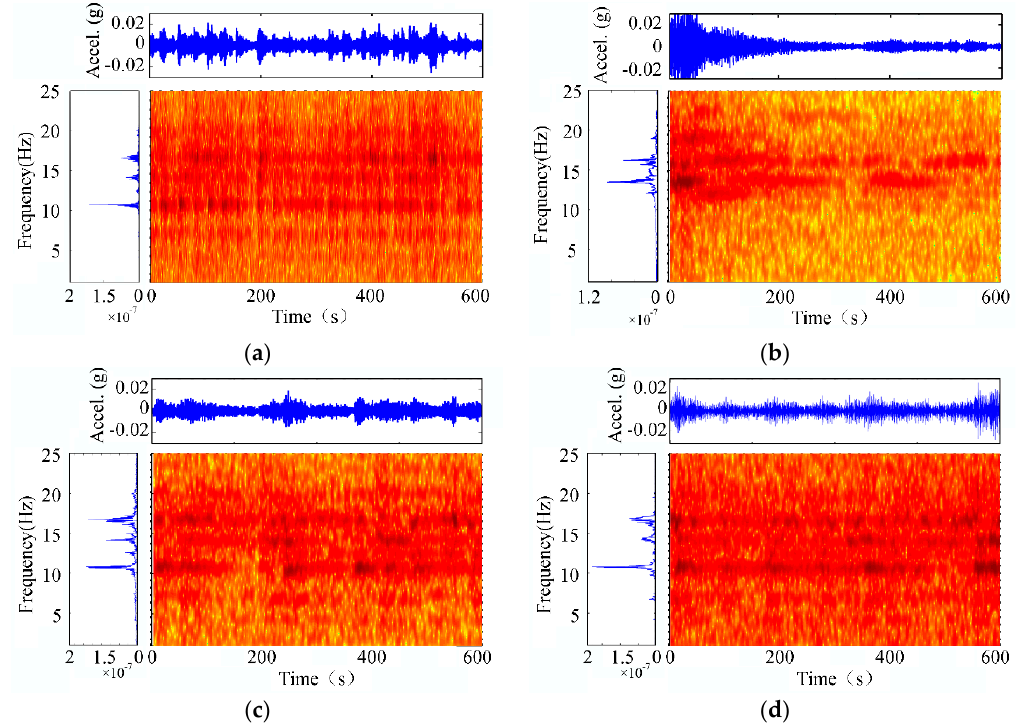
Figure 8. Spectrograms of frequencies, accelerations and power density functions of the sensors: ( a ) sensor 1; ( b ) sensor 2; ( c ) sensor 3; ( d ) sensor 4.